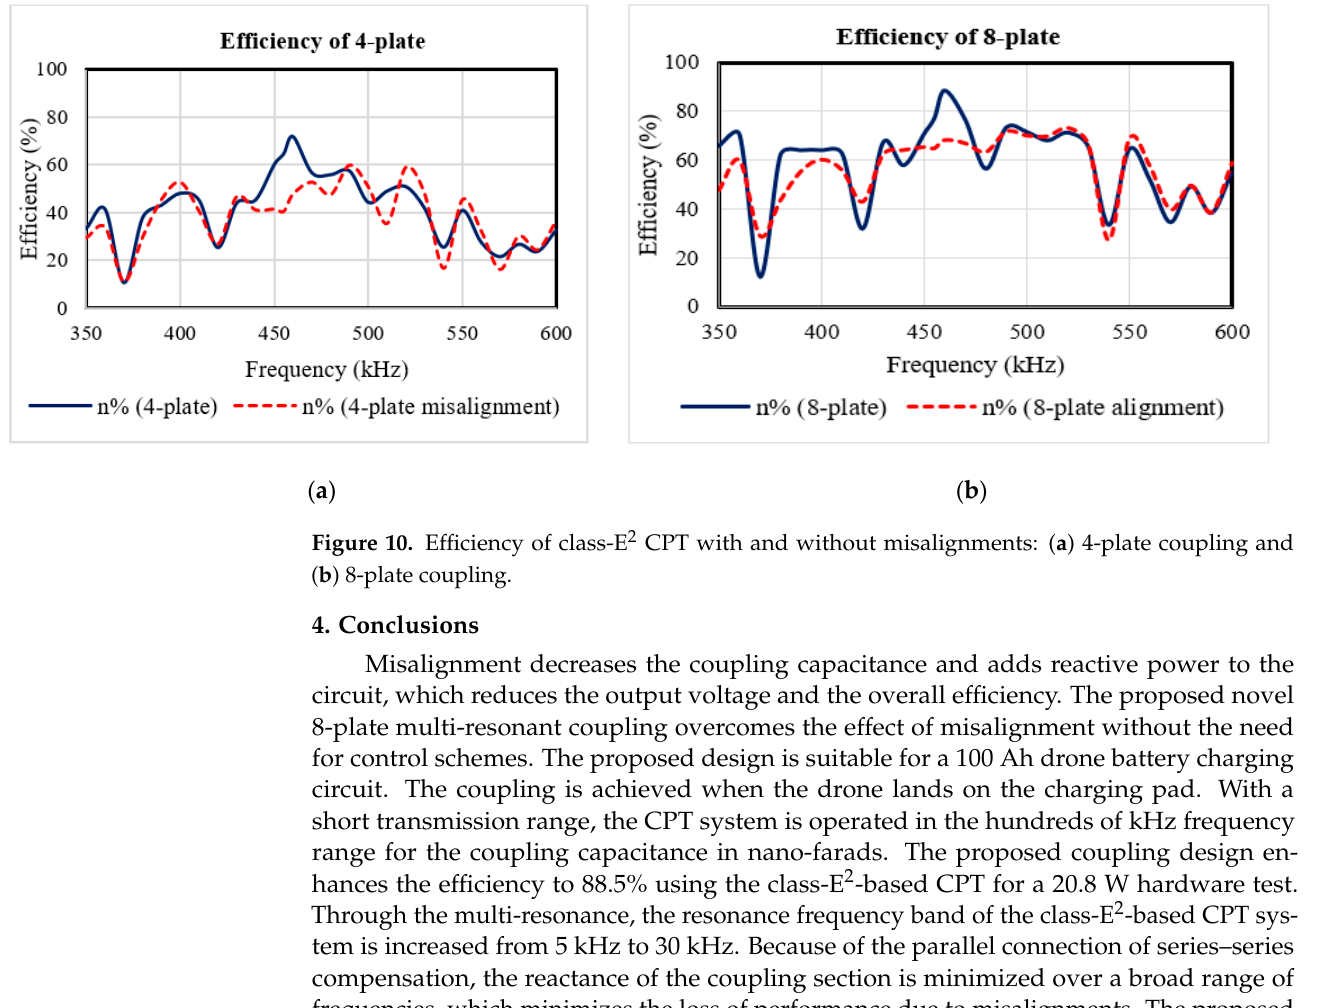
Figure 10. Efficiency of class-E 2 CPT with and without misalignments: ( a ) 4-plate coupling and ( b ) 8-plate coupling.